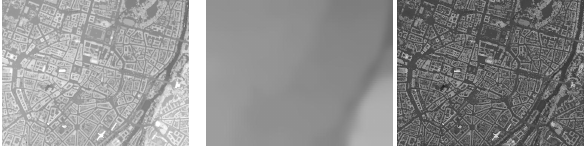
Figure 4. Corrected height map, DTM and nDEM, 2500 m × 2000 m each